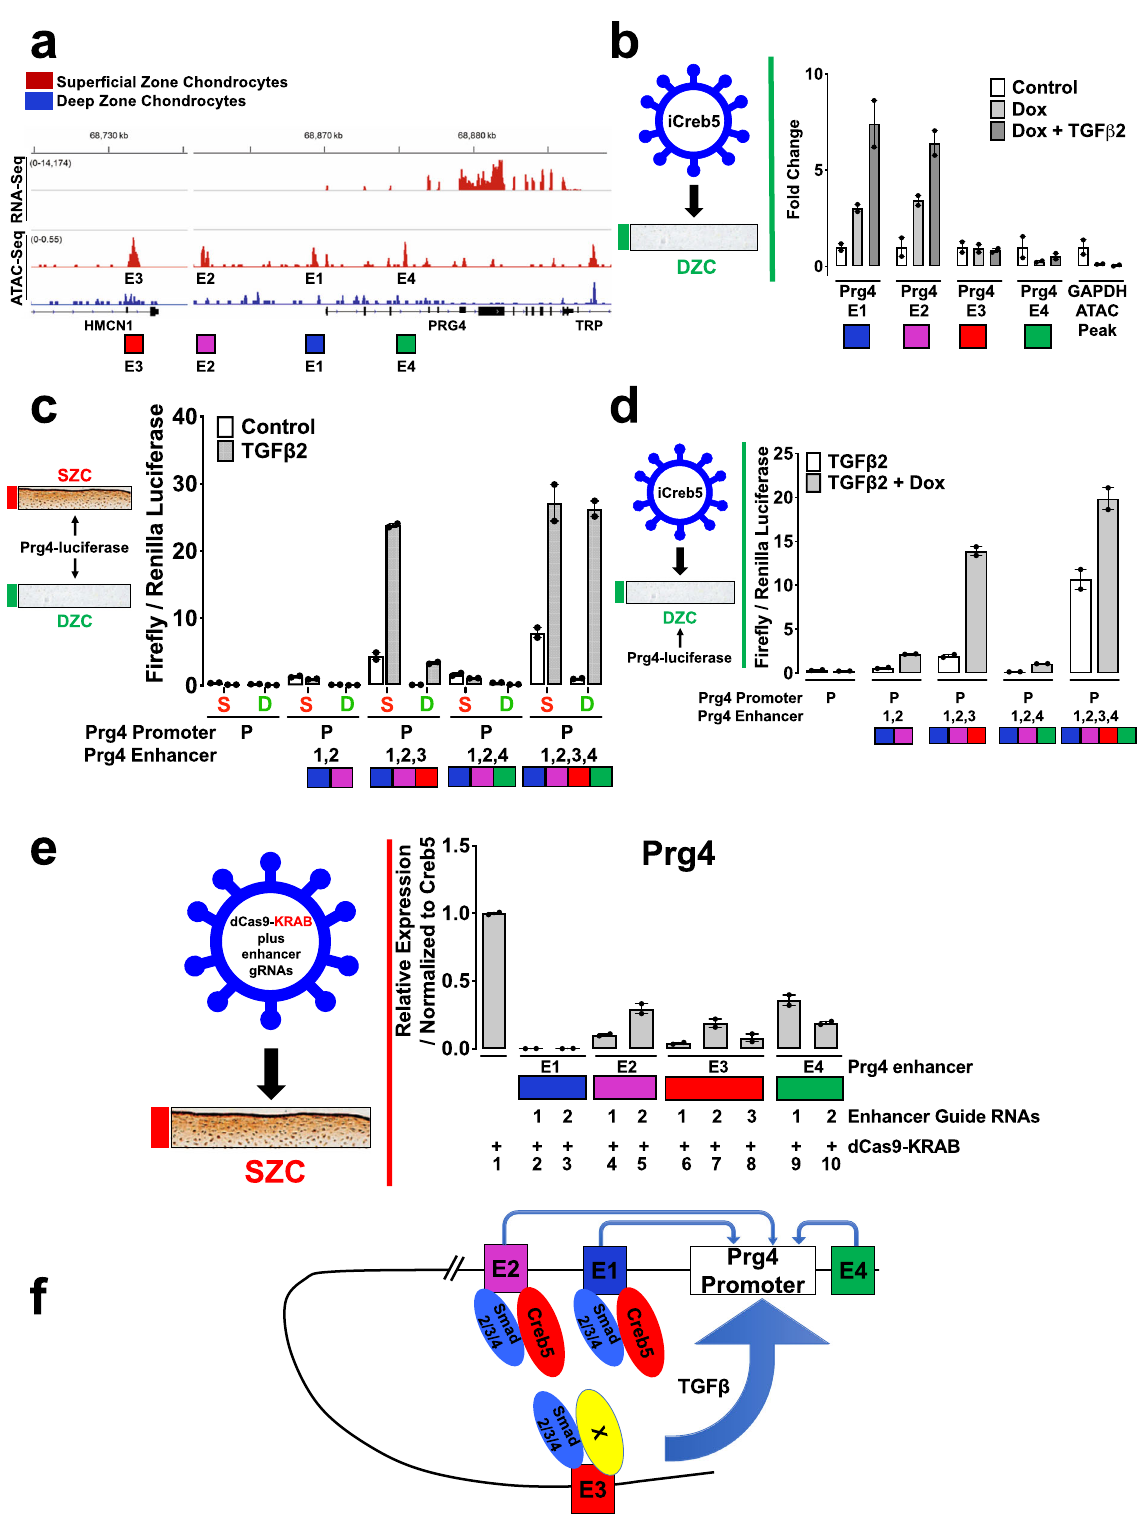
TGF- β signaling to promote Prg4 expression in super fi cial zone bovine articular chondrocytes. In developing mouse knees, Creb5 is expressed in the articular perichondrium, in super fi cial cells of the prospective meniscus, and in synovial fi broblasts that line the joint cavity; the same tissues that express Prg4 2,4,44 . Thus, Creb5 is present in the tissues that express Prg4 in murine, bovine, and